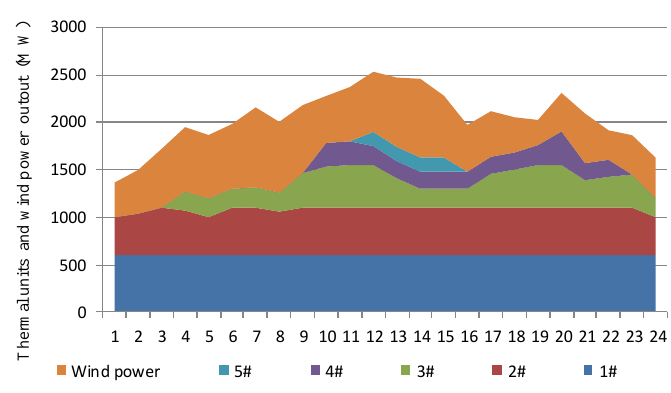
Figure 6. Thermal units and wind power output in Case 3.